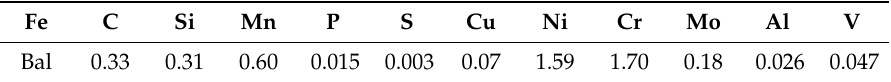
Table 3. Chemical composition of ingot used for ingot casting, wt%.